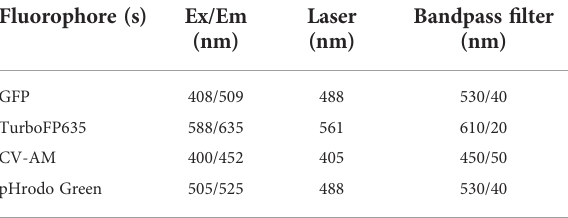
TABLE 2 Excitation and emission properties of fl uorescent probes utilized. Fluorophore